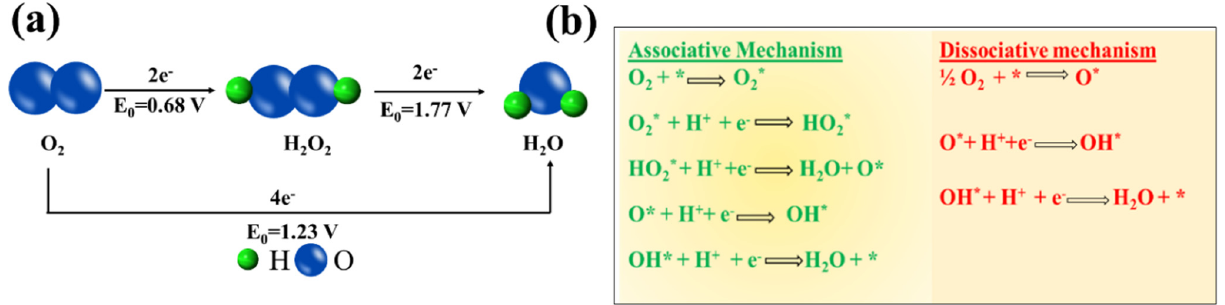
Figure 1. ( a )Scheme of the ORR mechanism by direct pathway and indirect pathway, ( b ) ORR mech- Figure 1. ( a ) Scheme of the ORR mechanism by direct pathway and indirect pathway, ( b ) ORR anism on the catalyst surface (* notation denotes a site on the catalyst surface). mechanism on the catalyst surface (* notation denotes a site on the catalyst